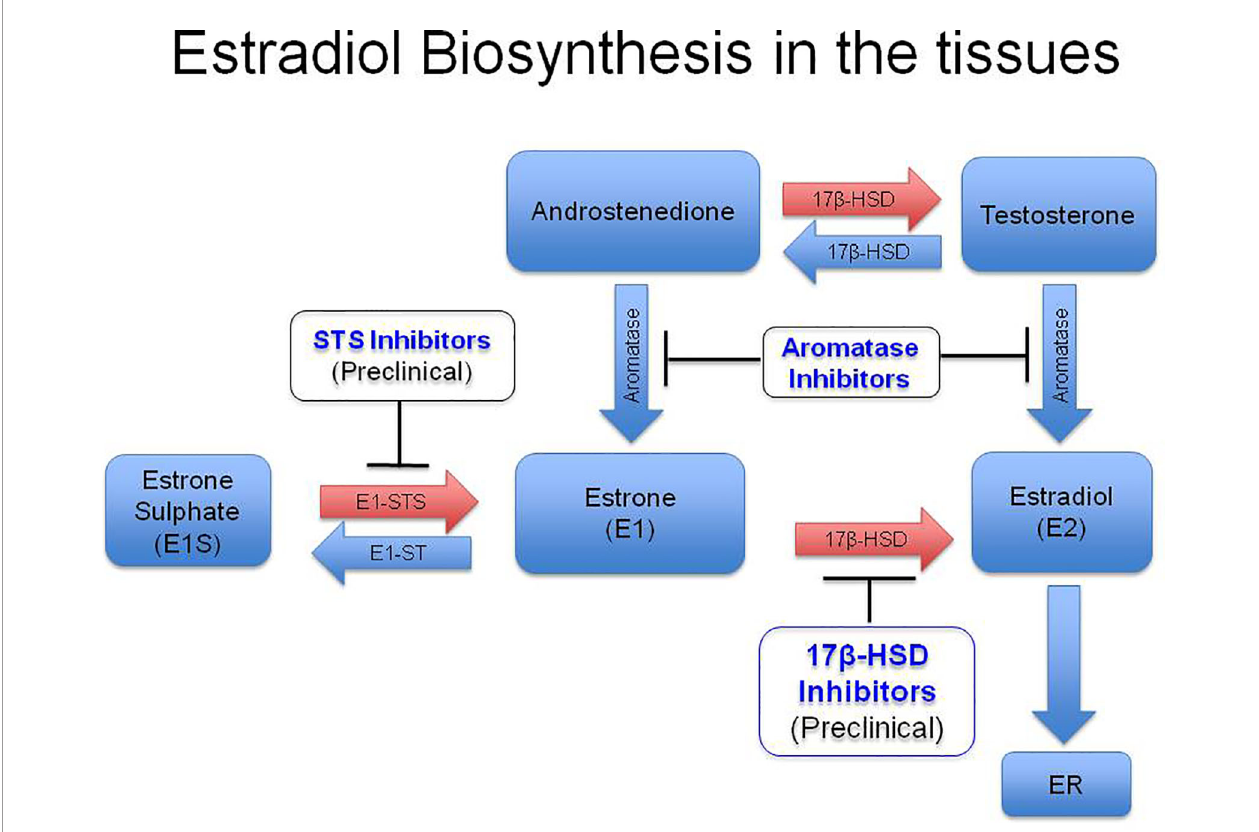
FIGURE 2 | Diagrammatic representation of biosynthesis of estradiol in the peripheral tissues. High levels of circulatory E1S (estrone sulfate) has been reported especially in post menopausal women. Estrone sulfatase (STS) converts E1S into estrone (E1) in the peripheral tissues, which subsequently gets reduced to estradiol (E2) by type I 17 b -Hydroxysteroid Dehydrogenase (17, b -HSD). Estradiol in the tissues binds to intracytoplasmic or membrane Estrogen Receptors (ERs) and carries out its function. Development of STS inhibitors and 17, b -HSD inhibitors are in the preclinical stage. E1, Estrone; E2, Estradiol; E1S, Estrone sulphate; E1 STS, Estrone sulfatase; E1 ST, (Estrone sulfotransferase). (Reproduced from: Jayshree R.S., et al., Med J Obstet Gynecol 2020; 8(2): 1136. DOI: 10.1007/978-981-13-